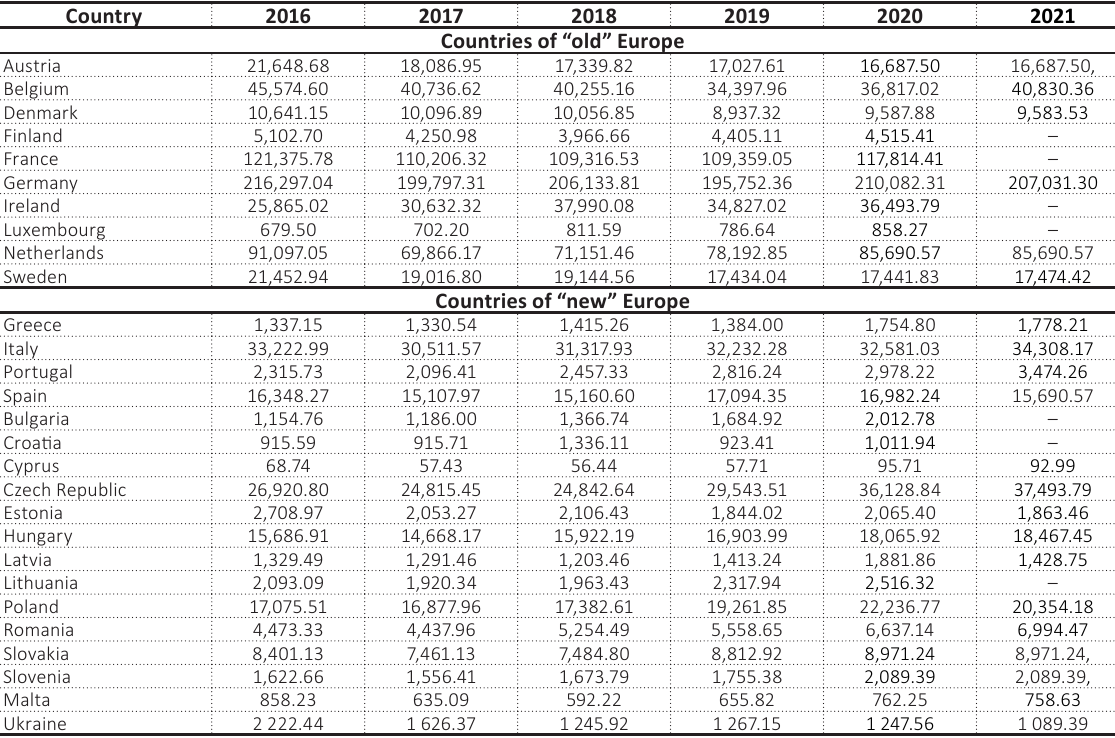
Table А1. Export of highly technological goods, million US dollars (Х1) Country